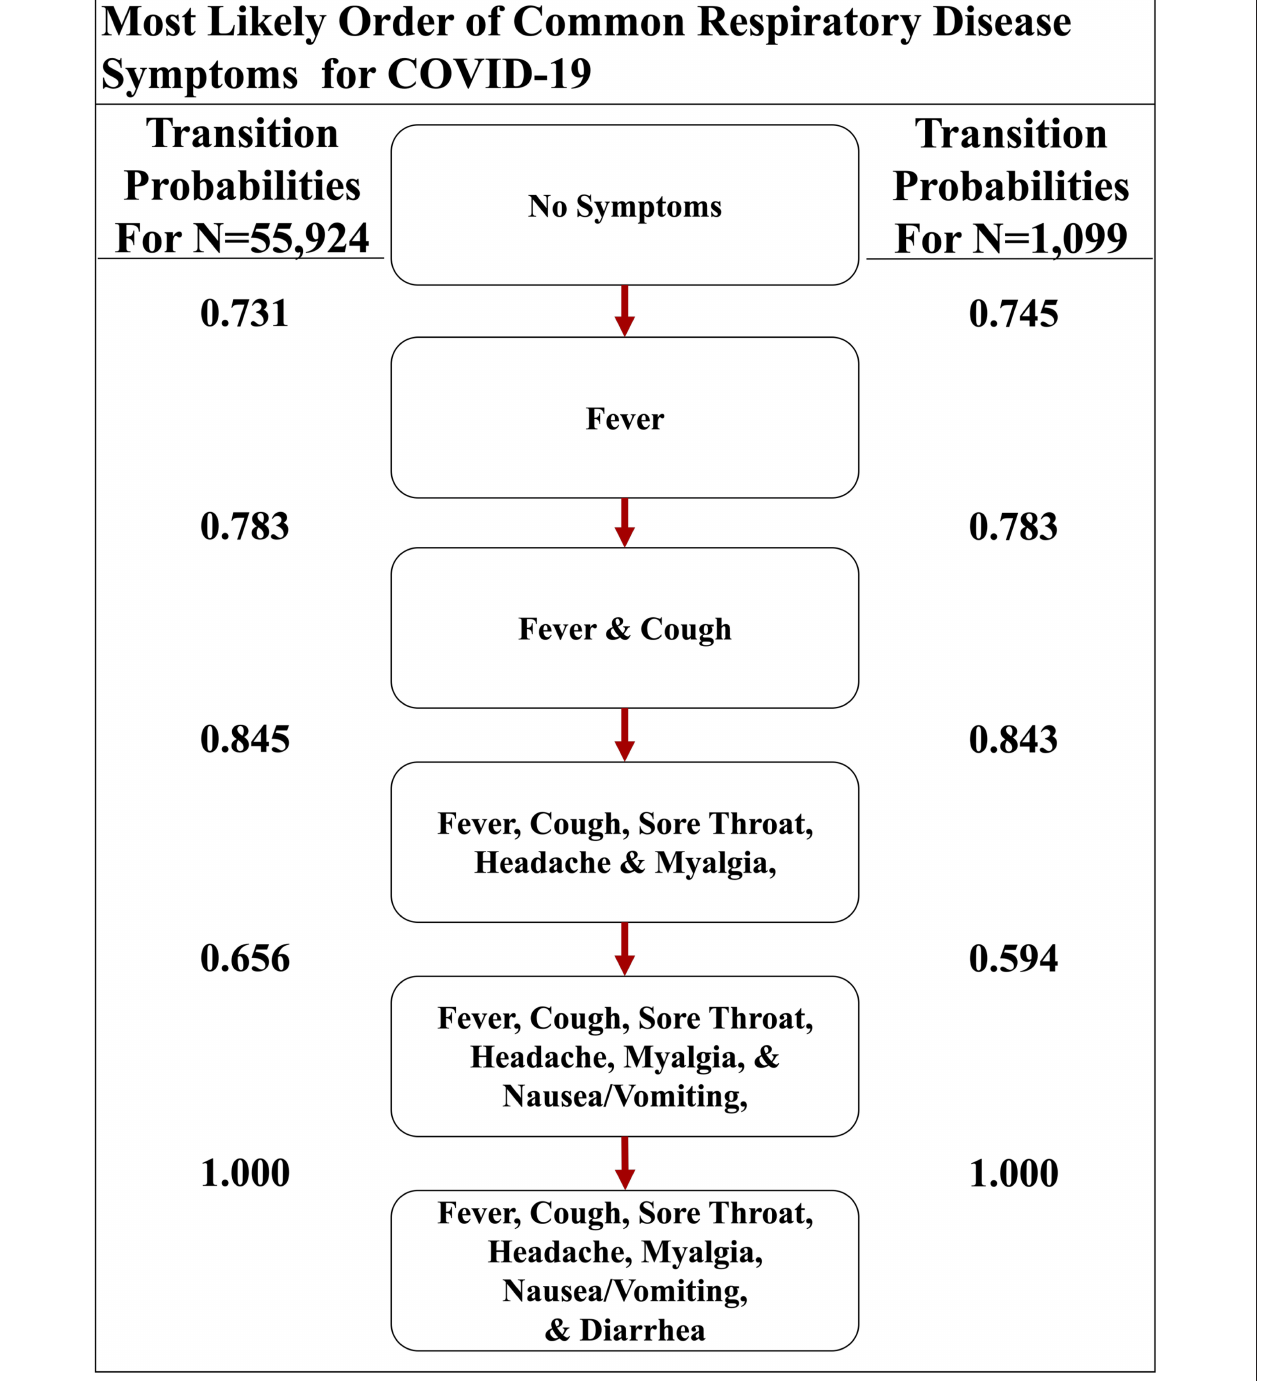
FIGURE 4 | The most likely path of common respiratory symptoms in COVID-19. The most likely path of seven common symptoms of COVID-19, determined by the transition probabilities that are also listed between nodes, of two datasets here. that fever is most likely to occur first, followed by an undetectable is similar to the other coronavirus-related diseases ( Figure 5C